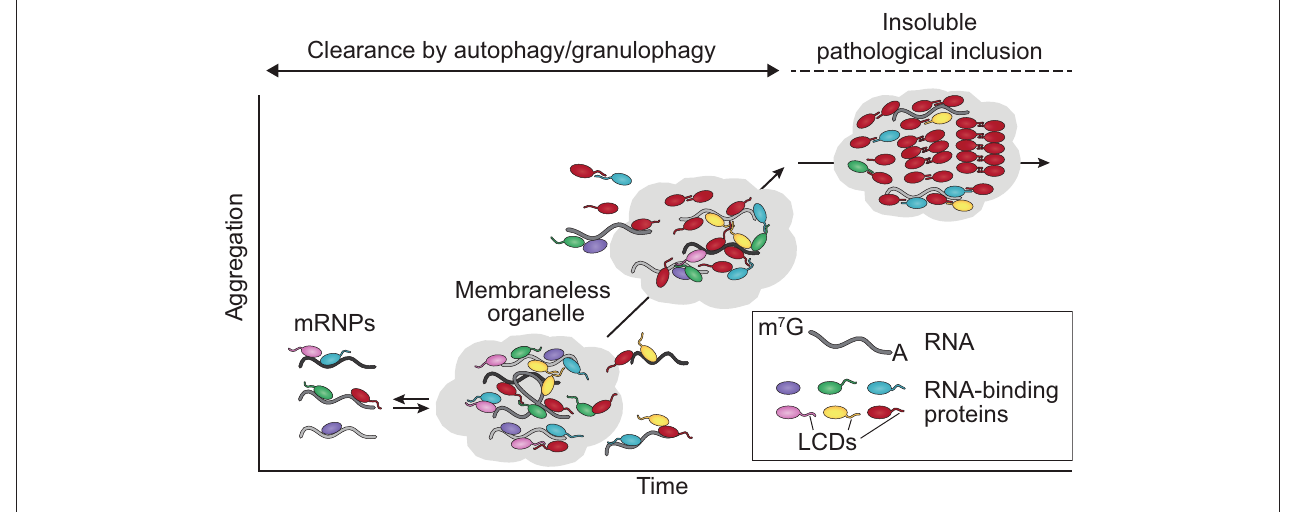
FIGURE 2 | ALS mutations alter the dynamics and function of membraneless organelles. RNA-binding proteins associate with mRNA, forming mRNPs that are transported to the cytosol. The hnRNPs discussed in this review contain LCDs that mediate phase separation, contributing to the assembly/disassembly, dynamics, and liquid properties of membraneless organelles such as stress granules. Stress granules that begin forming aggregates and are no longer capable of being disassembled by liquid-liquid phase separation mechanisms are cleared by autophagy/granulophagy. Disease-causing mutations can trigger the assembly of aberrant or persistent membraneless organelles in which the high concentration and close interactions of the LCDs over time may promote the transition of aggregation-prone proteins (e.g., TDP-43, FUS) to pathogenic amyloid fibrils. mRNP, messenger ribonucleoprotein particle; LCDs, low complexity